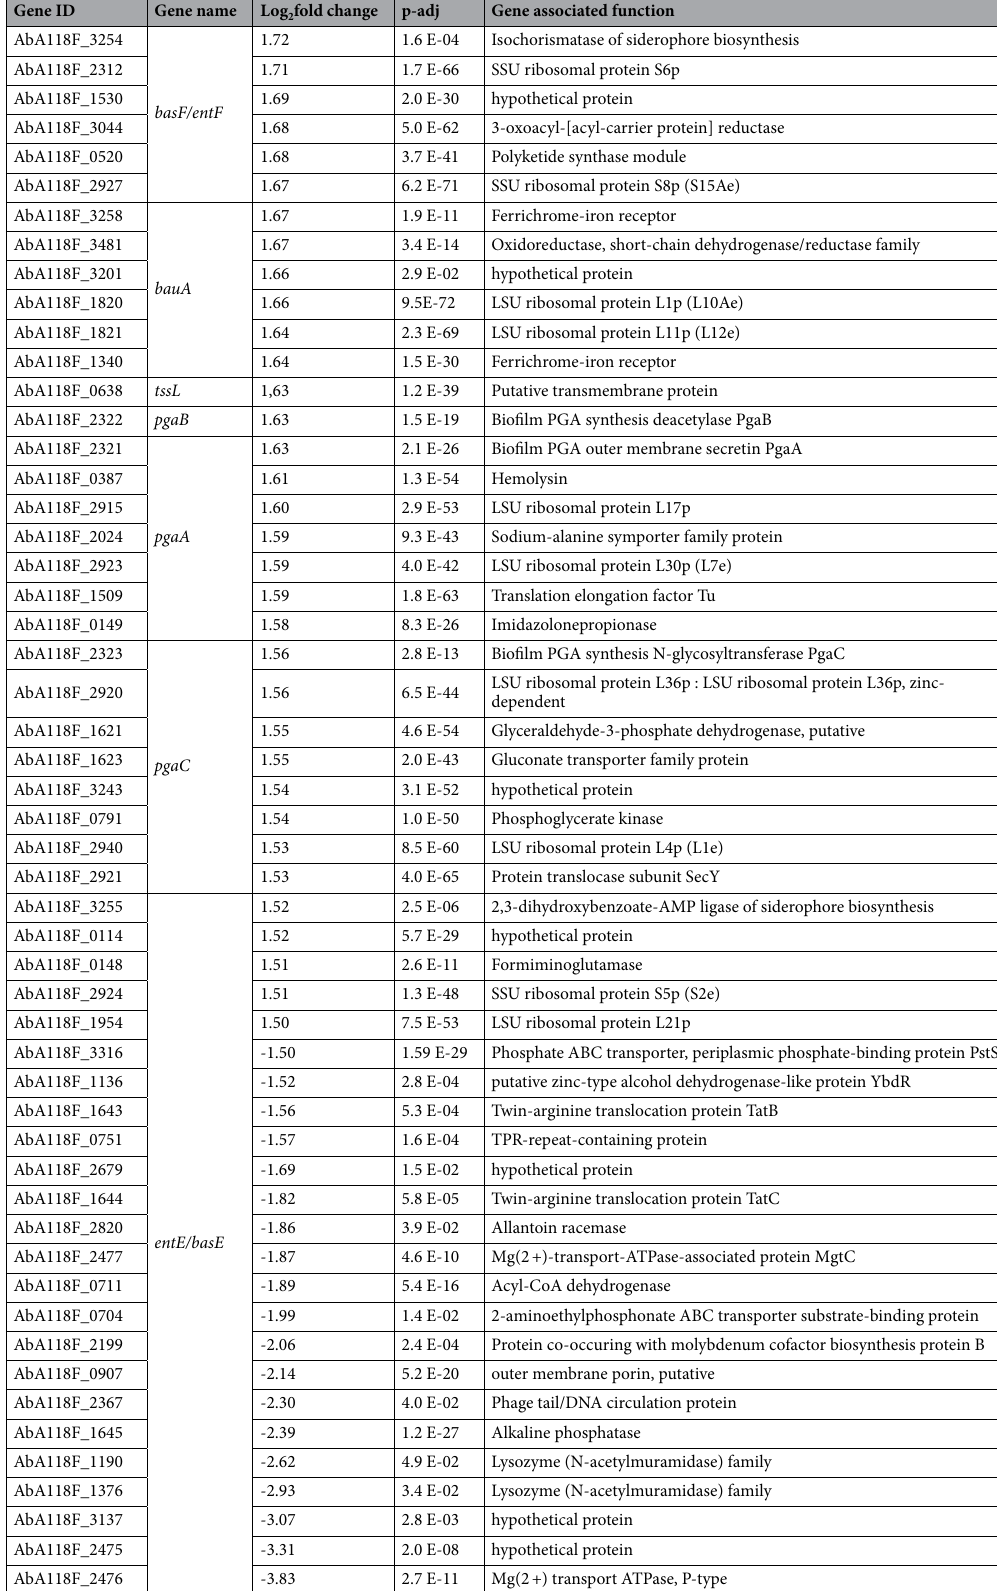
Table 1. CSF regulated genes in A. baumannii A118. The table lists all A. baumanii A118 ORFs that are regulated by CSF with a Log2FC ≥|1.5|, p <